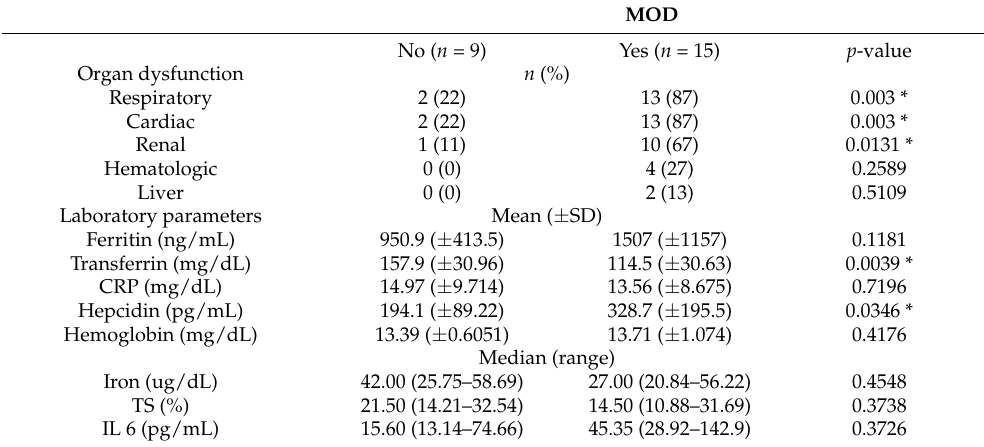
Table 2. Organ dysfunction and laboratory parameters on admission in patients without anemia.